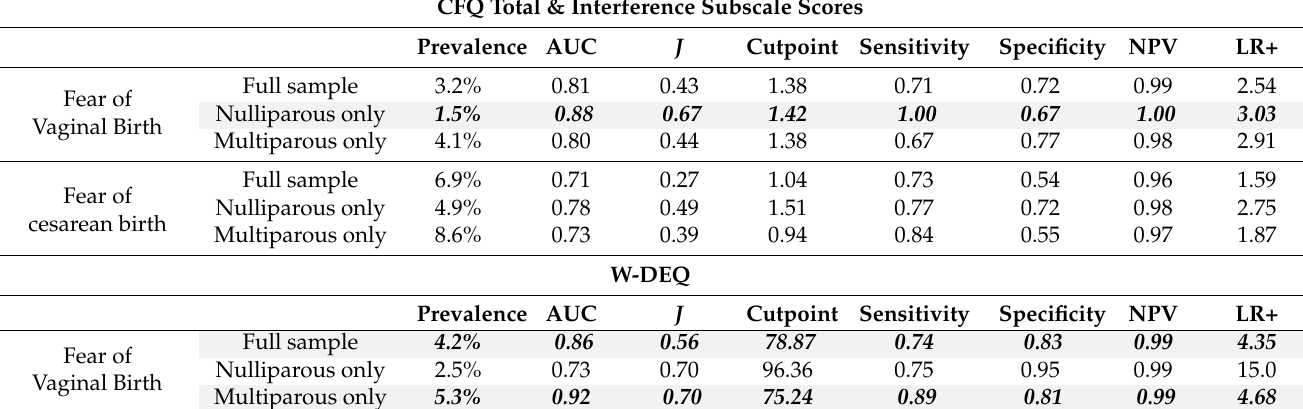
Table 5. ROC Results for the Childbrith Fear Questionnaire (CFQ; Total and Interference subscale scores) and the Wijma Delivery Expectations Questionnaire (W-DEQ), separately for fear of vaginal and fear of cesarean birth (subclinical and full diagnostic criteria